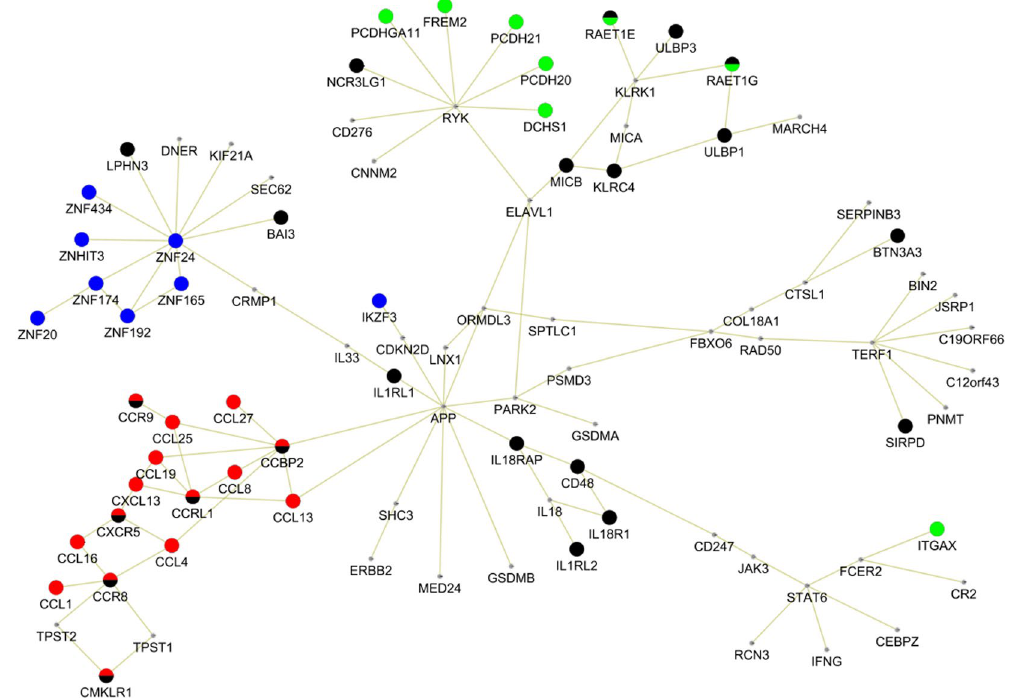
Figure 3. Clusters of functionally-related genes in the COA module. Four genes cluster including a total of 44 out of 91 module genes were identified using DAVID 13, 41 . The genes coloured in black belong to the Immune Response cluster; the genes coloured in red belong to the Chemokines/Chemotaxis cluster; the genes coloured in green belong to the Cadherins/Cell-adhesion cluster and the genes coloured in blue belong to the Zinc finger proteins/Transcription regulation cluster. Genes belonging to multiple clusters are marked by mixed